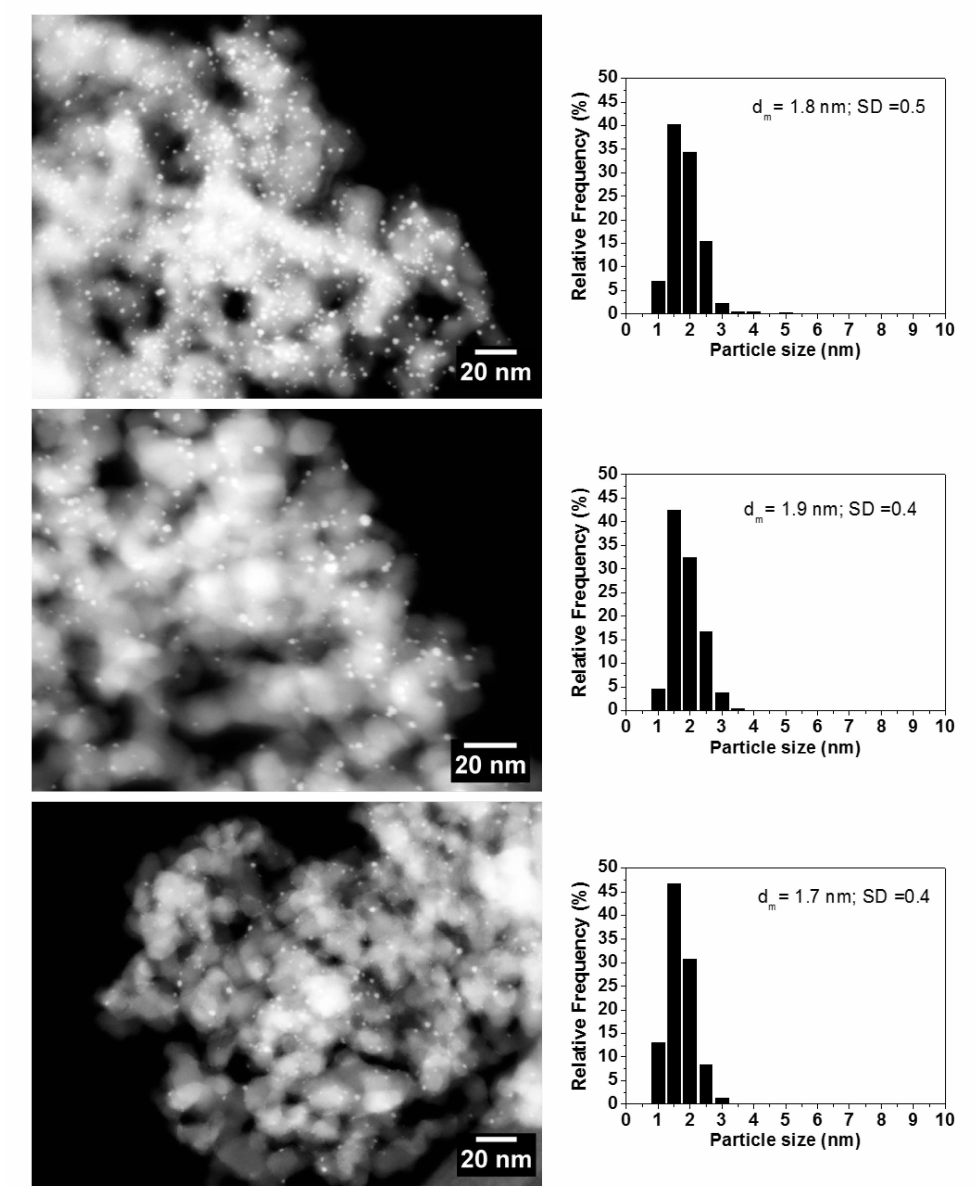
Figure 6. Representative HAADF-scanning transmission electron microscopy (STEM) micrograph and particle size distribution of Au 4 Cu 1 / Al 2 O 3 (top), Au 1 Cu 1 / Al 2 O 3 (middle), Au 1 Cu 4 / Al 2 O 3